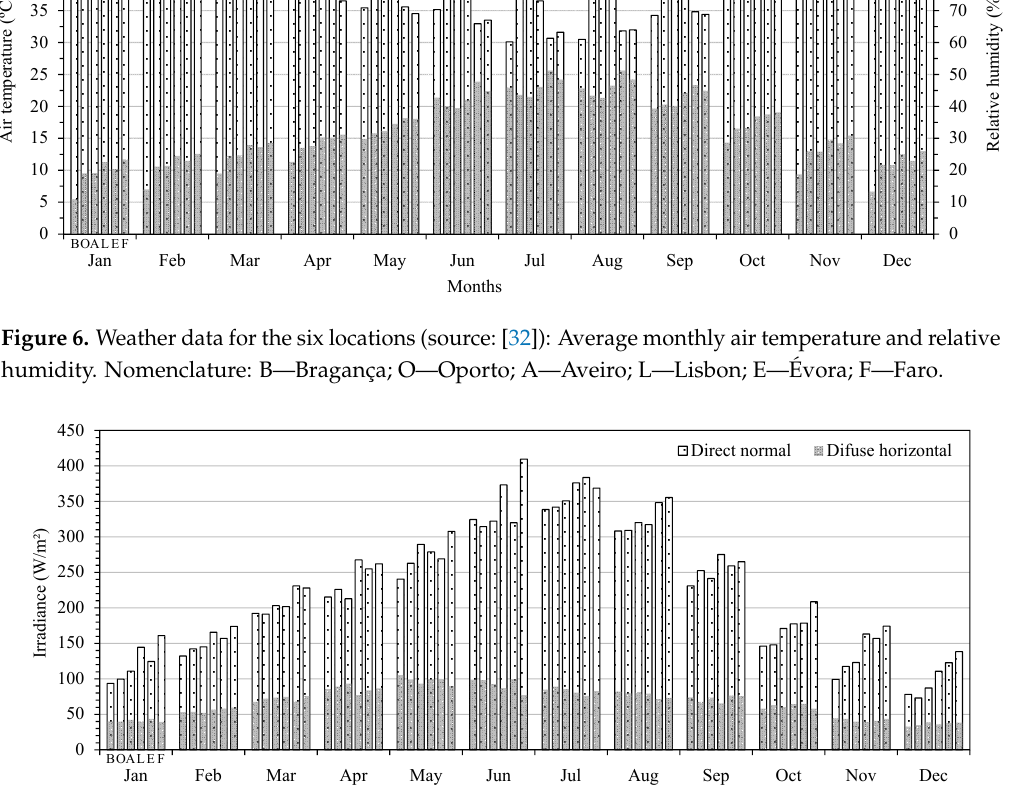
Figure 7. Weather data for the six locations (source [32]): Average monthly solar irradiance, direct normal and diffuse horizontal irradiance. Nomenclature: B—Bragança; O—Oporto; A—Aveiro; L—Lisbon; E—Évora; F—Faro.